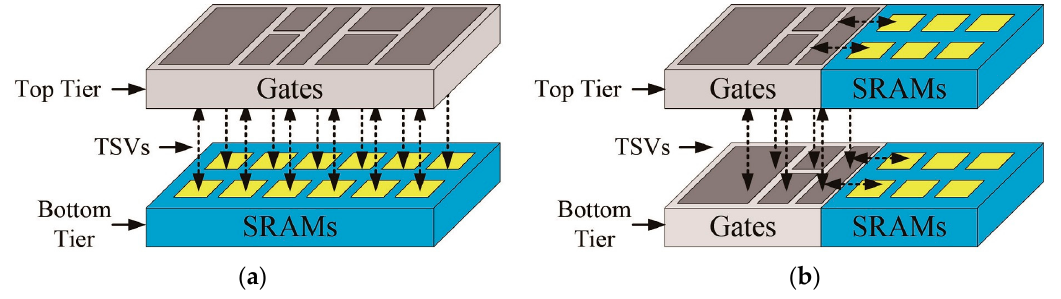
Figure 7. ( a ) The conventional macro-level partitioning method; and ( b ) the proposed pipeline-level partitioning method.